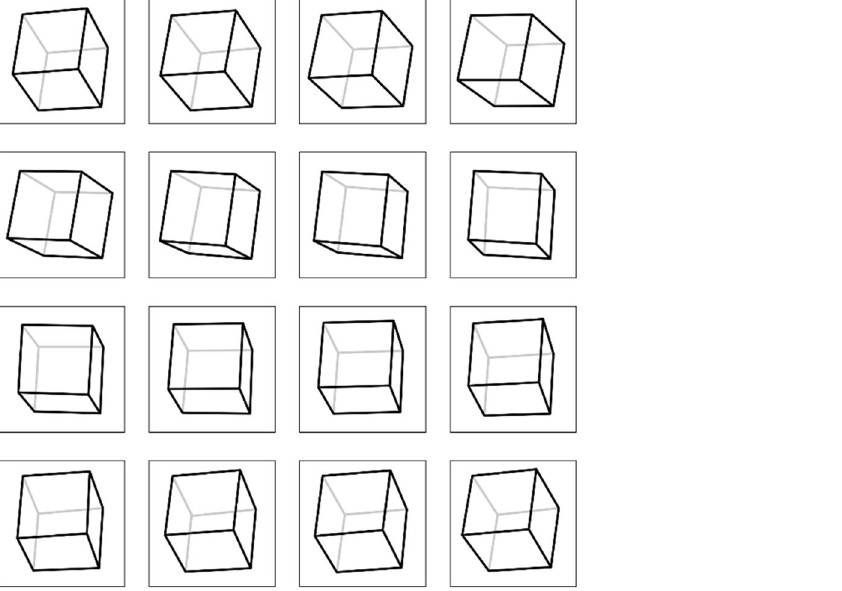
Figure 5. Fragment of the 2D-frames of the